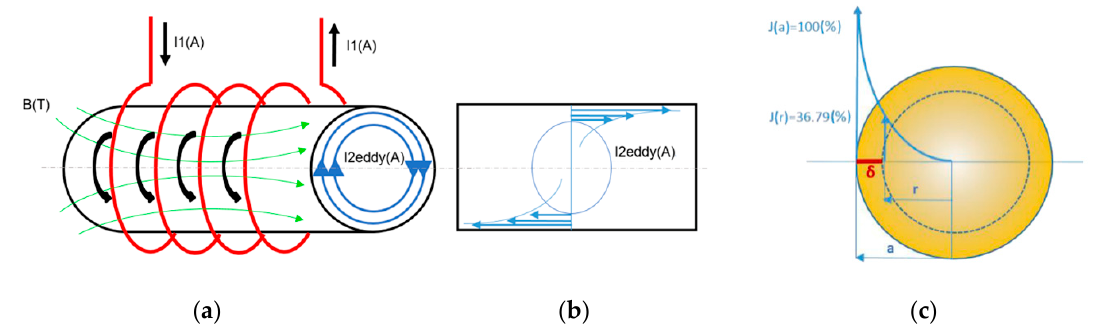
Figure 1. General principle of induction heating: schematic depiction of coil and heated workpiece ( a ); detailed depiction of eddy currents ( b ); graphical depiction of skin effect ( c ).